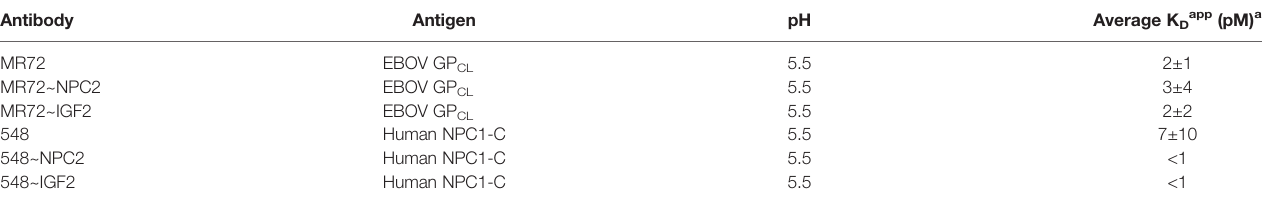
TABLE 1 | Kinetic binding constants for Ab:antigen interaction determined by BLI.